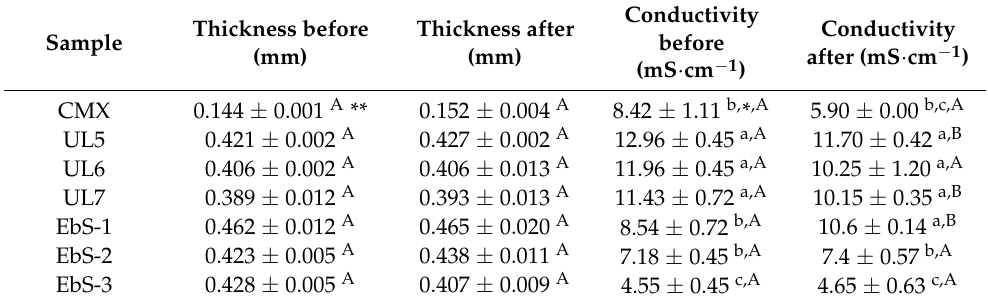
Table 5. Thickness and conductivity of hCEMs and CMX reported before and after electrodialysis.